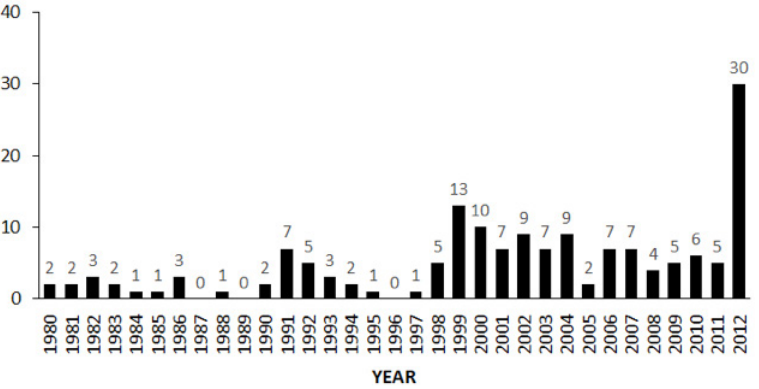
Figure 1: Recorded attacks on water critical infrastructure (adapted from (Abrams and Weiss, 2008, Gleick and Heberger, 2014, Kroll, 2010, Weiss,